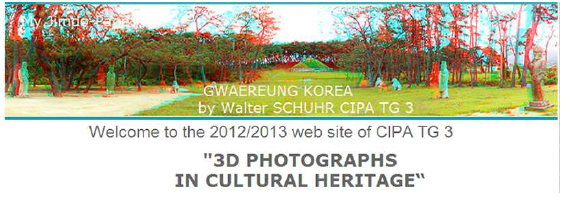
Figure 17. 1 st page of the web site www.3dphoto.jimdo.com